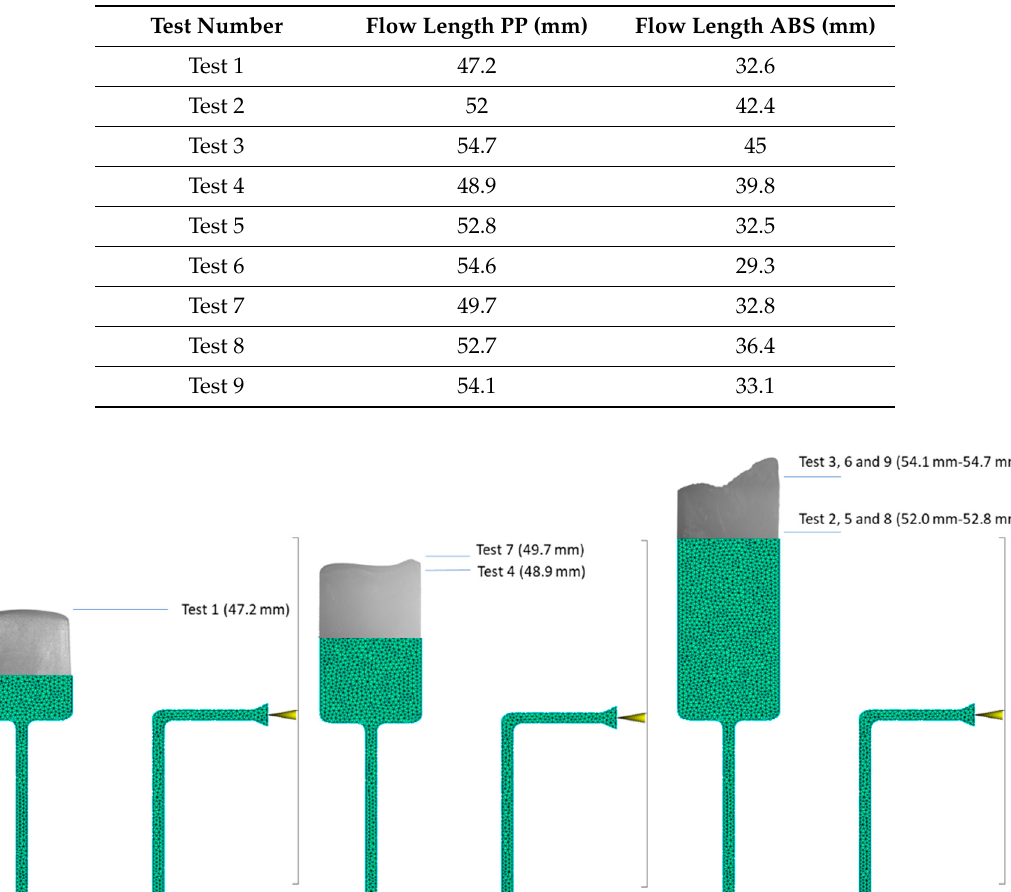
Test 3 Figure 10. Flow fronts for test parts 1 and 3.